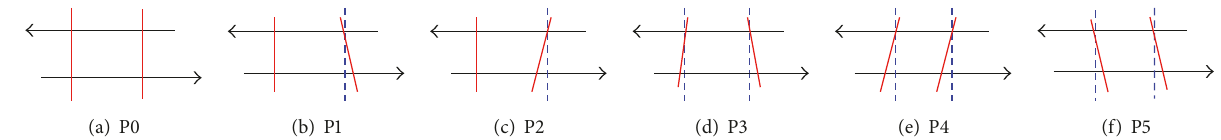
Figure 2: Patterns of single-lap double-bolt